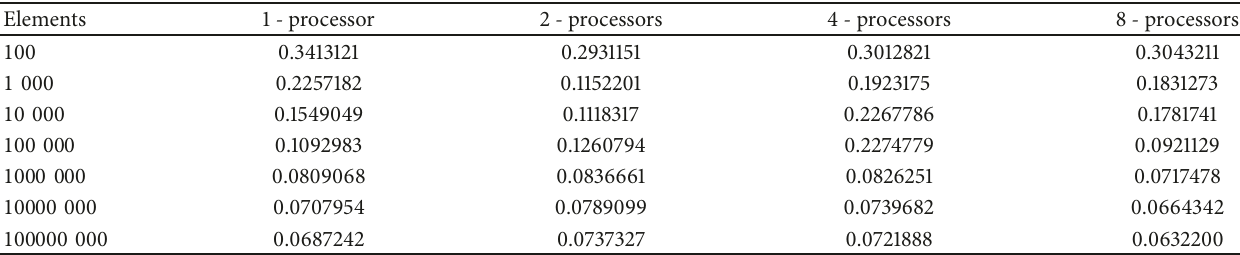
Table 3: Coefficient of variation for sorting time [ms].